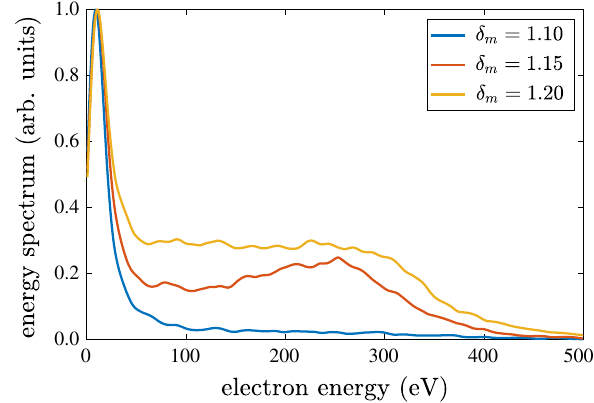
FIG. 7. Central cell design of the experimental E structure with slits opened on the sidewall, as in the CST PIC simulation setup. 1, the sidewall section assigned with SEE properties; 2, the side dark current monitor; 3, field emission area source of electrons.